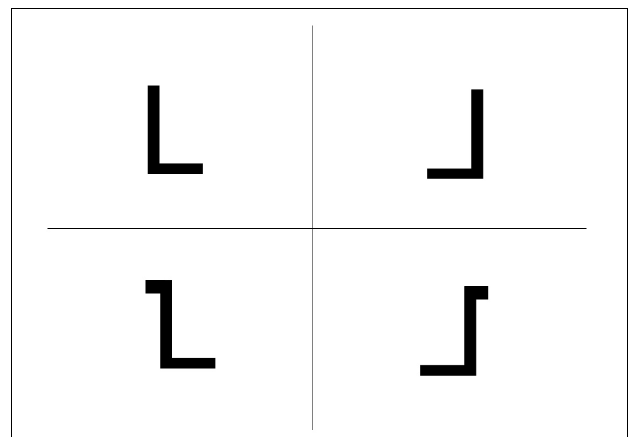
FIGURE 1 | The letter recognition test (example: letter